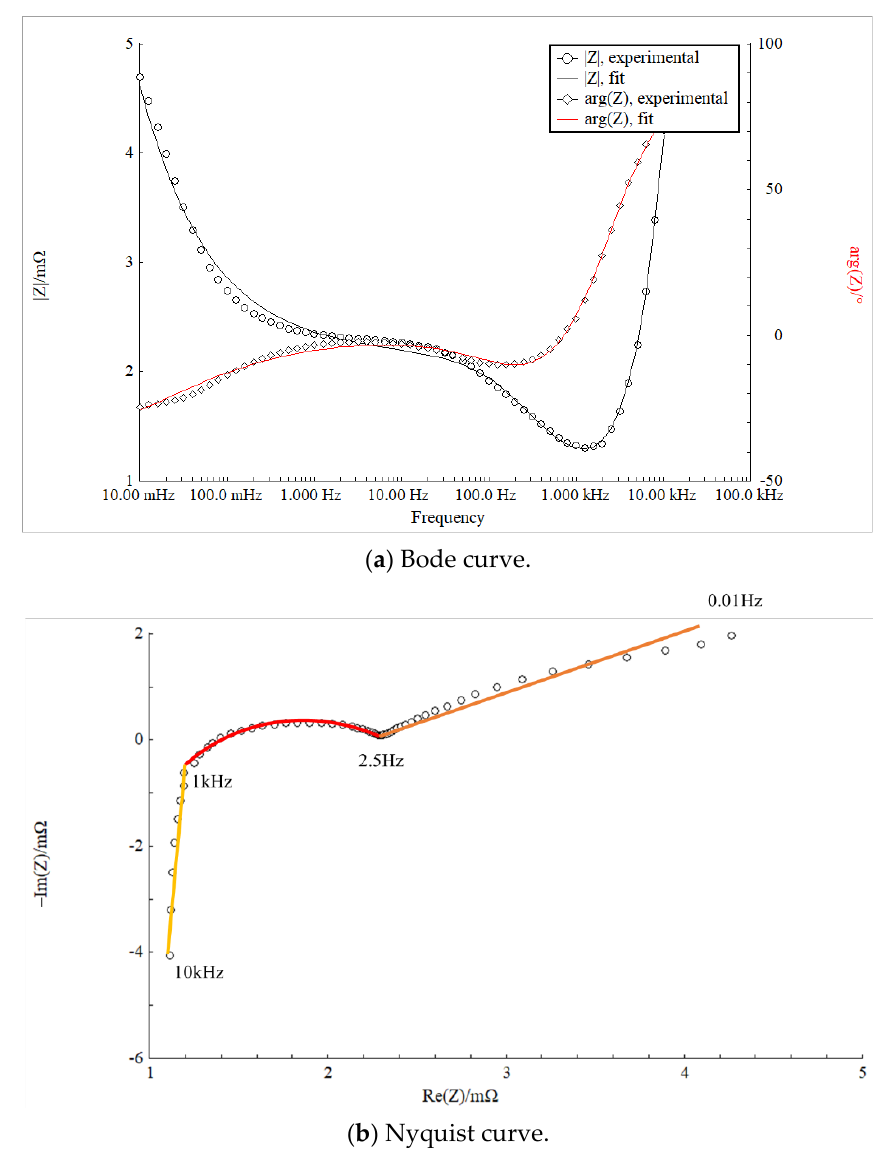
Figure 1. An example of Bode and Nyquist curves of a fully charged lithium-ion